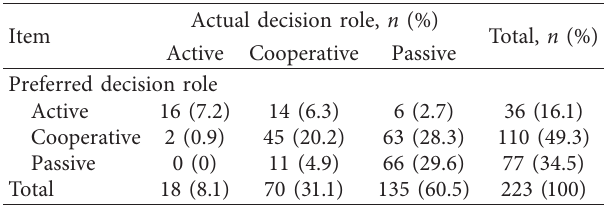
Table 2: Preferred and actual roles of ICU patients’ families in decision